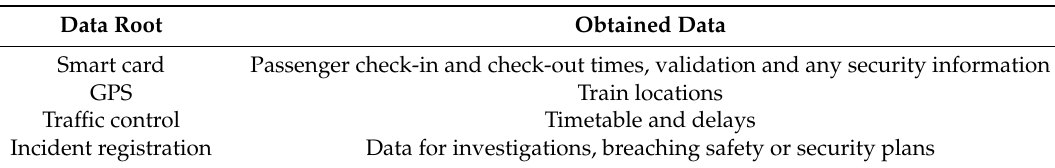
Table 1. Examples of the data in the railway stations.